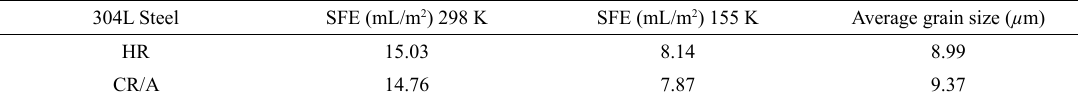
Table 2. SFE values and grain sizes of 304L steel.